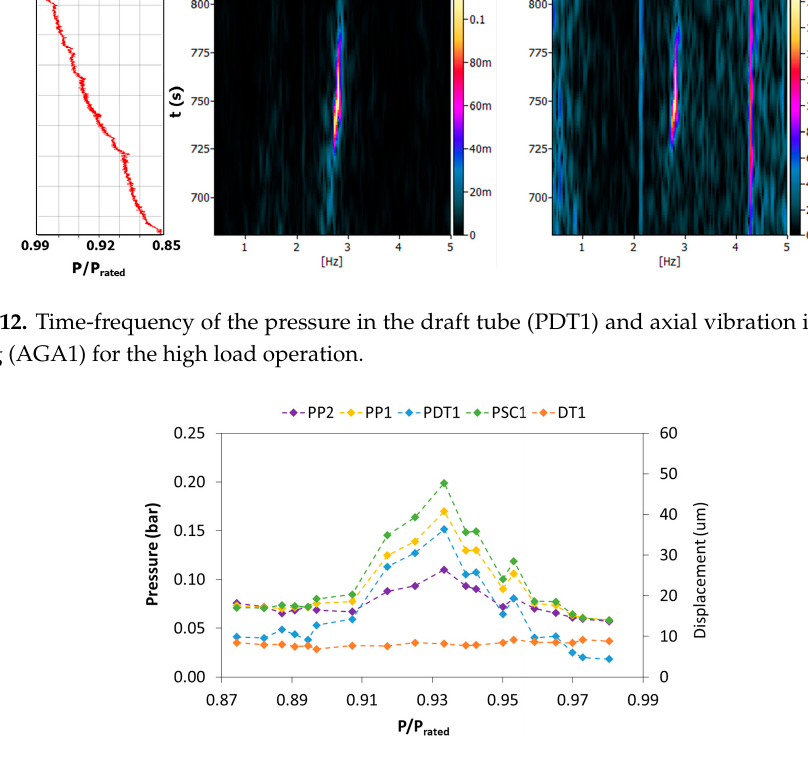
Figure 13. RMS values (2.2 to 4 Hz) of pressure in the draft tube (PDT1), in the spiral casing (PSC1) and in the penstock (PP1 and PP2) and displacement of the shaft (DT1) for the high load operation.